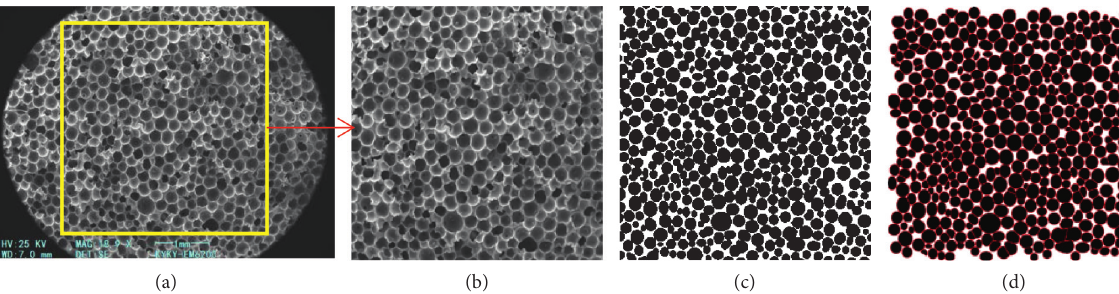
Figure 3: SEM image processing steps for the polyurethane polymer microstructure. (a) Raw SEM image; (b) cropped image; (c) reconstructed image; (d) removed and segmented